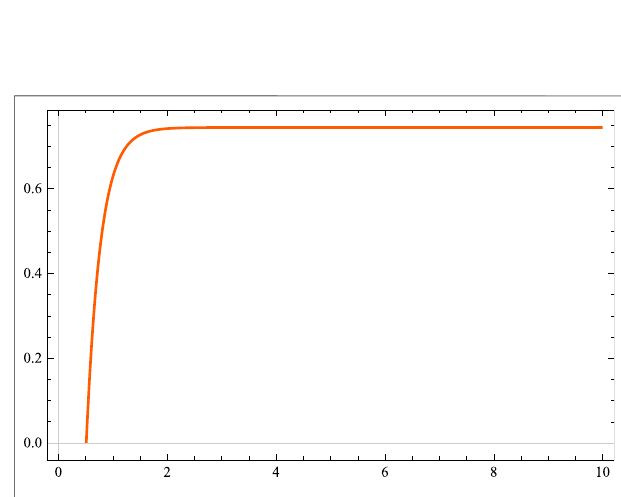
FIGURE 4 | Variation of displacement vector ( β 2 ) vs . time ( t